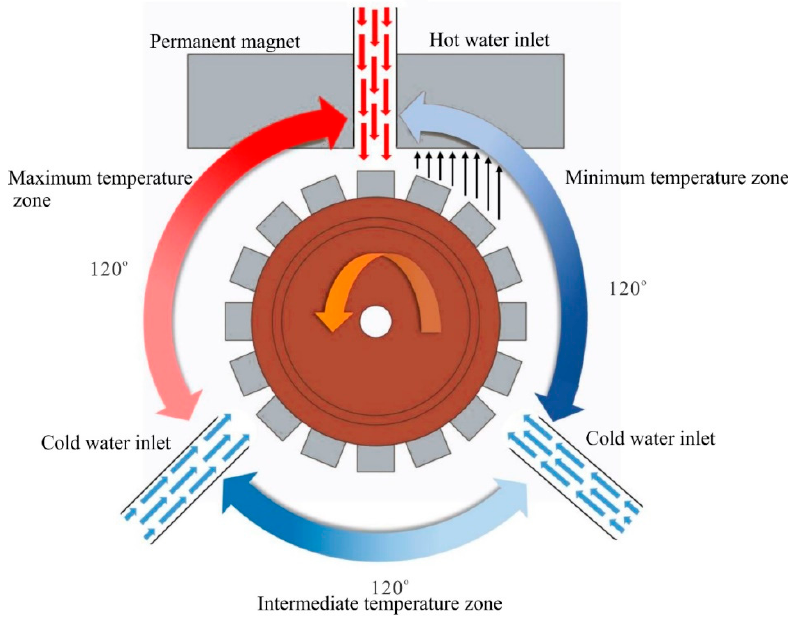
Figure 1. Schematic of thermomagnetic heat engine.